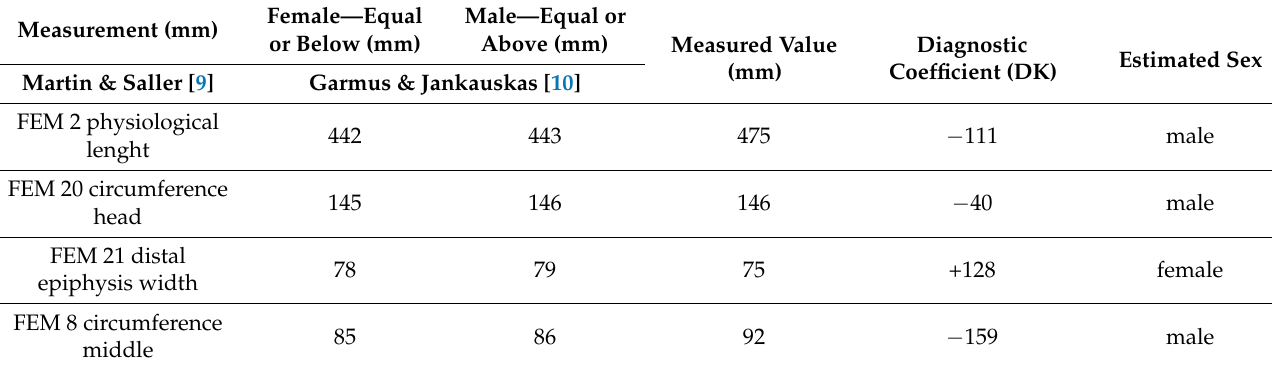
Table 2. Biological sex assessment from osteometric